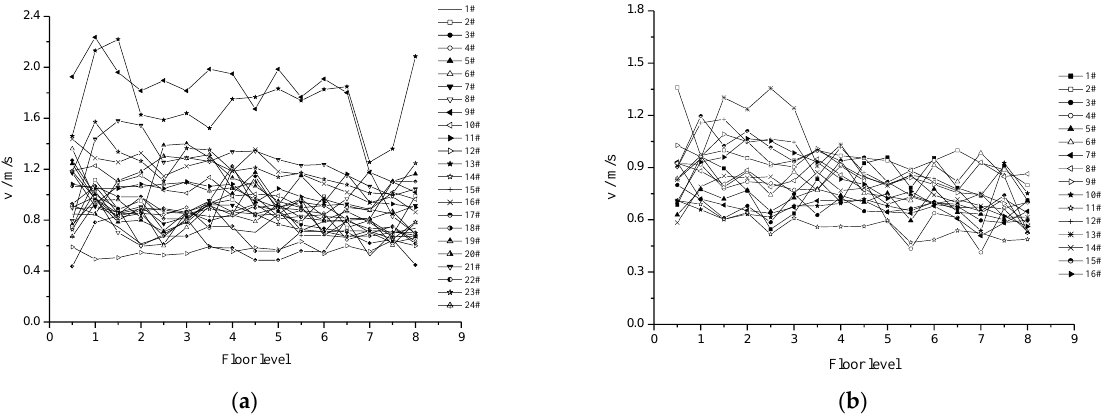
Figure 8. Ascending speed distributions of each participant in Group A along the climbing level (traveling over 8 floors). ( a ) Male; ( b ) female.